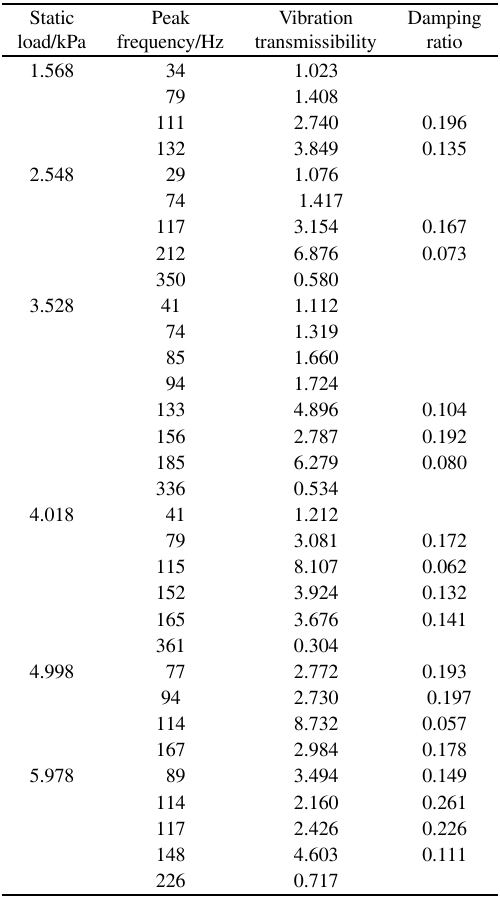
Table 3 Vibration transmissibility of X-PLY(B) corrugated